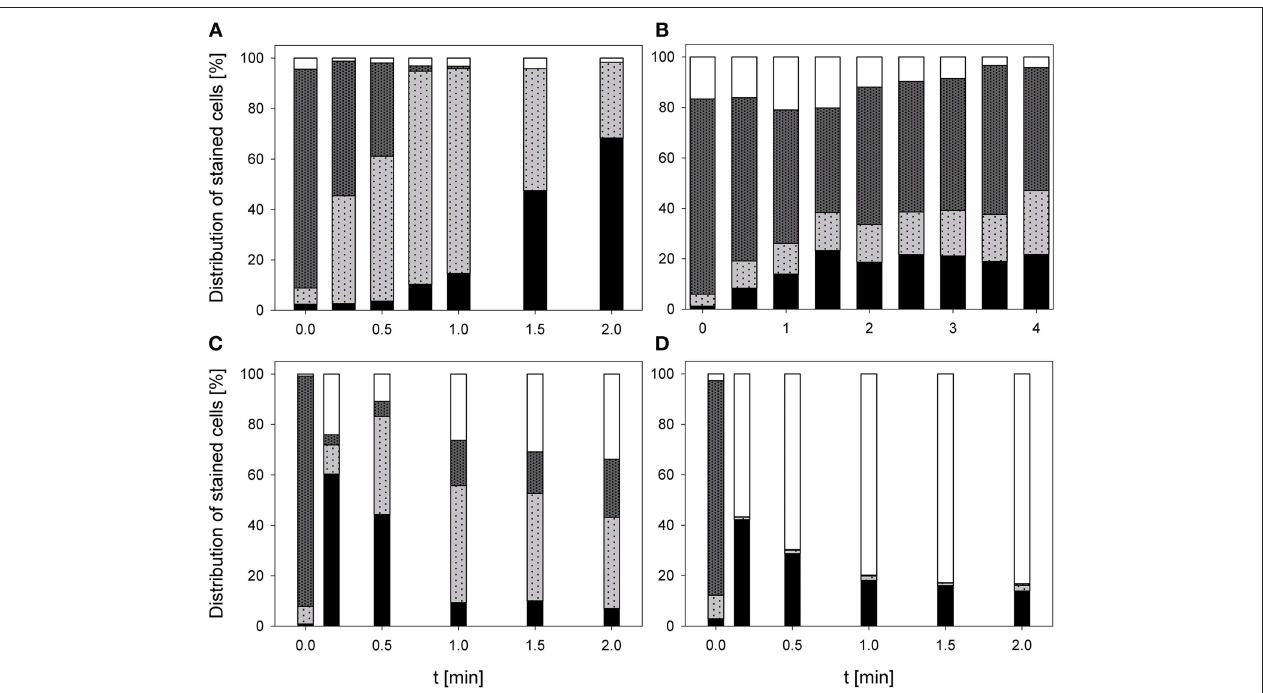
FIGURE 6 | Esterase activity and membrane integrity of E. coli after PAA treatment [(A) 10 ◦ C, 0.25% PAA], CAPP treatment [(B) 20 W], and treatment with ozonated water [(C) 3.8mg l − 1 O 3 (–); (D) 3.78mg l − 1 O 3 ( + )]. Black bars representing permeabilized cells without esterase activity; dotted gray bars representing permeabilized cells with esterase activity, dotted light gray bar representing intact cells with esterase activity, and white bars representing cells without fluorescence/cell fragments.